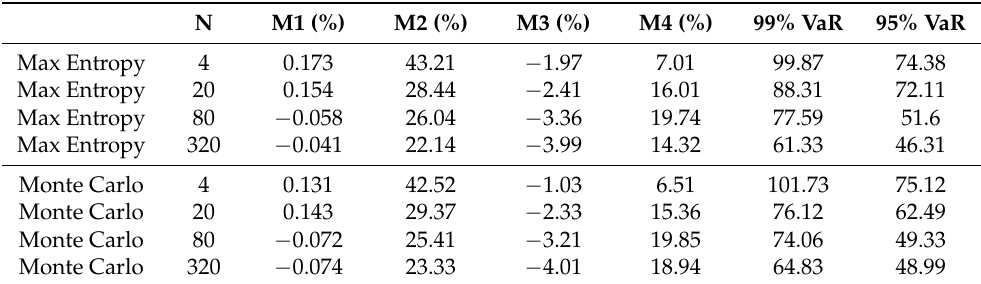
Table 1. Summary statistics: Moments (Mj for j = 1, 2, 3, 4) of the distribution of hedging error under the GG (generalised gamma) process. VaR: